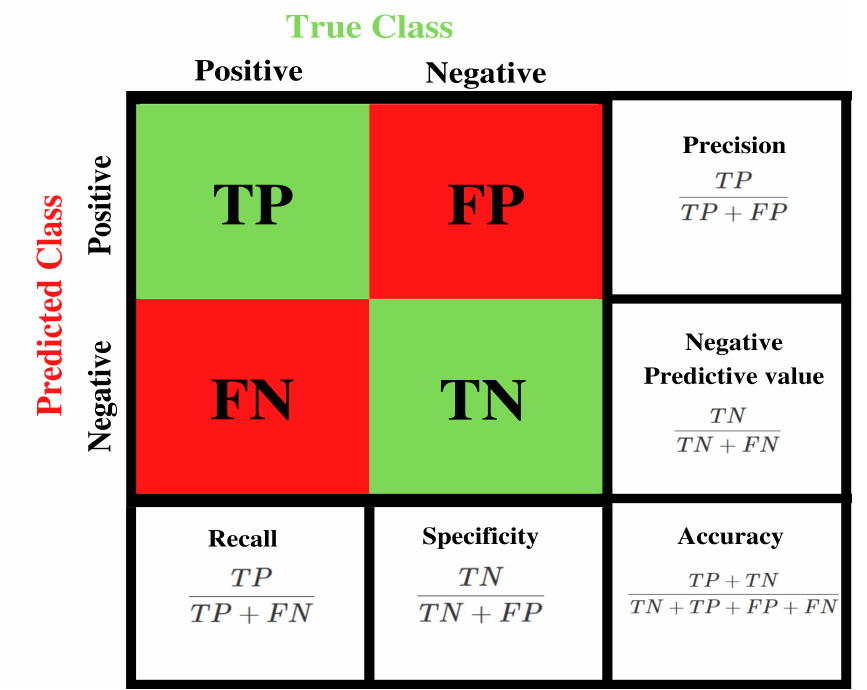
Figure 3. Confusion Matrix and the formulas of accuracy, precision, specificity, recall, and negative predictive value. TP refers to True Positives, TN refers to True Negatives, FP refers to False Positives, and FN refers to False Negatives. Table 2. Metrics used to evaluate the performance of threshold-based methods and machine learning models for the detection and classification of road surface anomalies